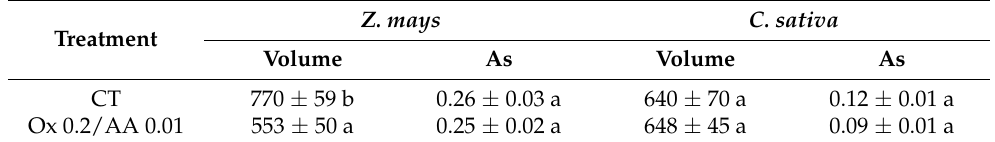
Table 4. Volume of leachates formed (mL) and concentrations of As (mg L − 1 ). The values are the means of three replicates and the error bars show ± standard deviations. The different letters within the same column represent different significance levels at p < 0.05 (Tukey’s test). Z. mays C. sativa Treatment